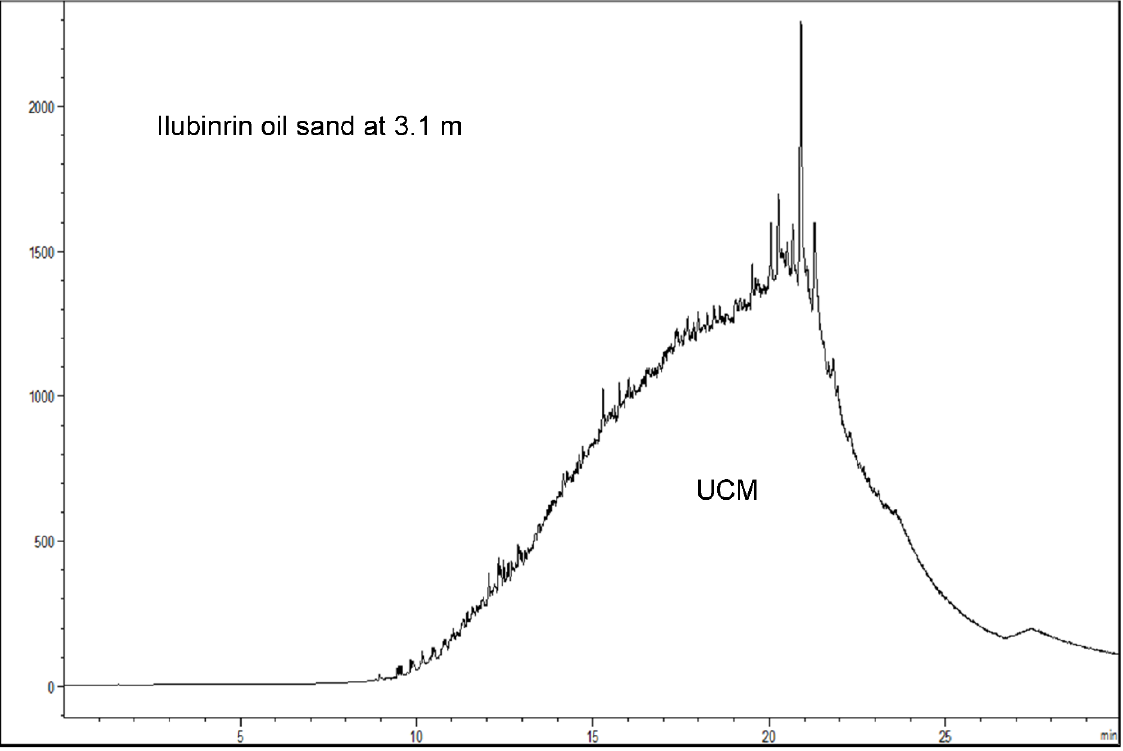
Figure 6. TD-GC result showing the chromatogram of Ilubinrin-1 oil sand at a depth of 3.1 m. The response intensity (pA) is displayed on the y -axis, while the retention time is shown on the x -axis in minutes. The presence of unresolved complex mixture (UCM) below the peaks suggests biodegraded oil.